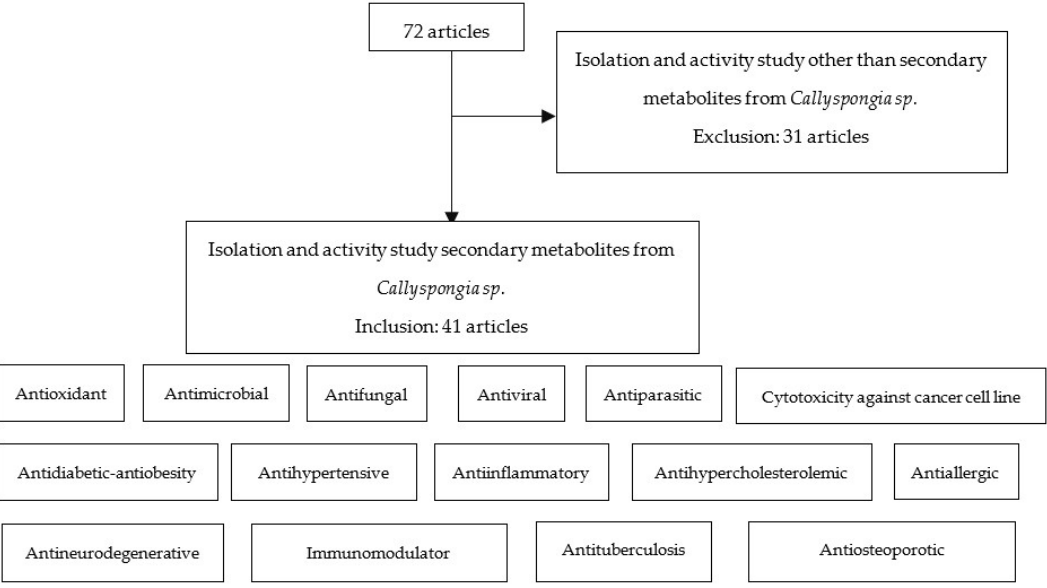
Figure 2. Method of screening information sources.